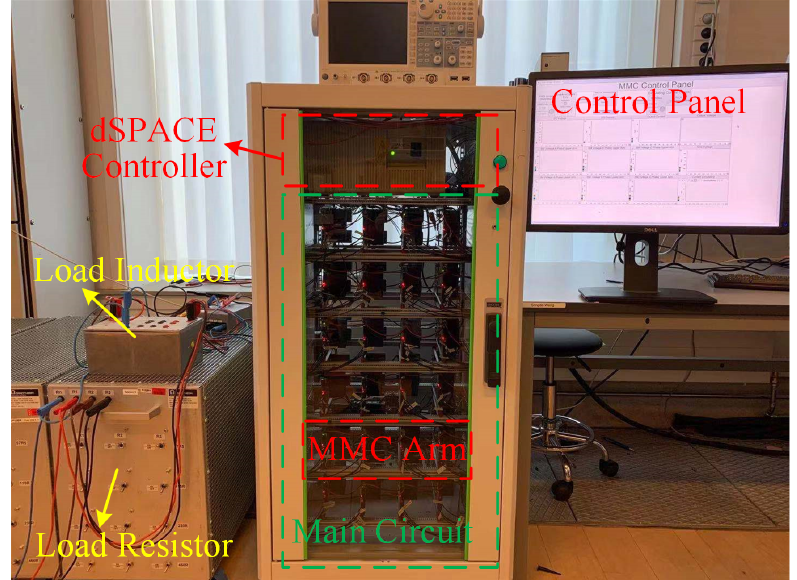
Figure 9. Experimental MMC setup.